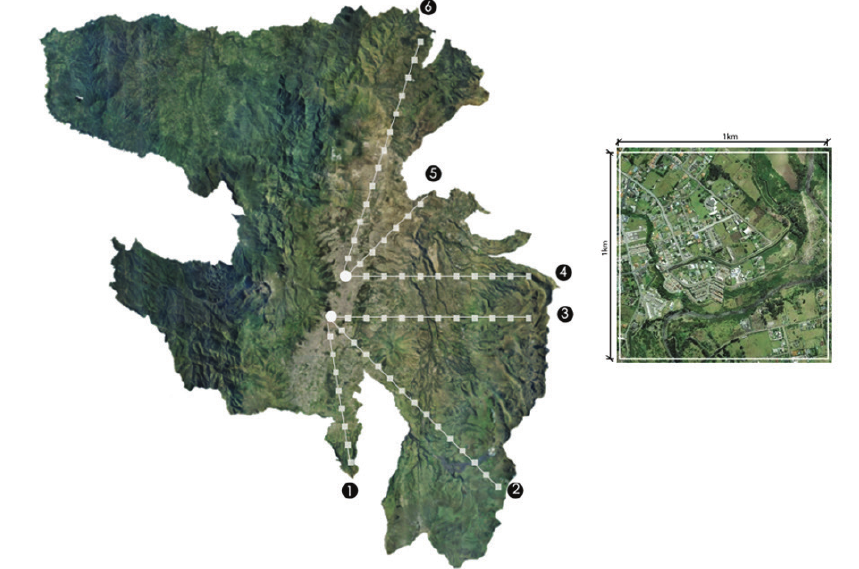
Figure 3. Defi nition of transects and sample